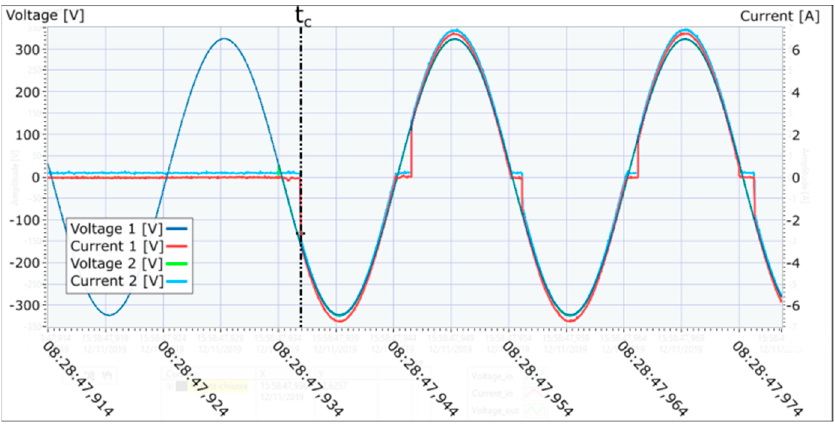
Figure 13. Instant ( t c ) at which the arc was formed (using the Bourns 2049-14 surge arrester).